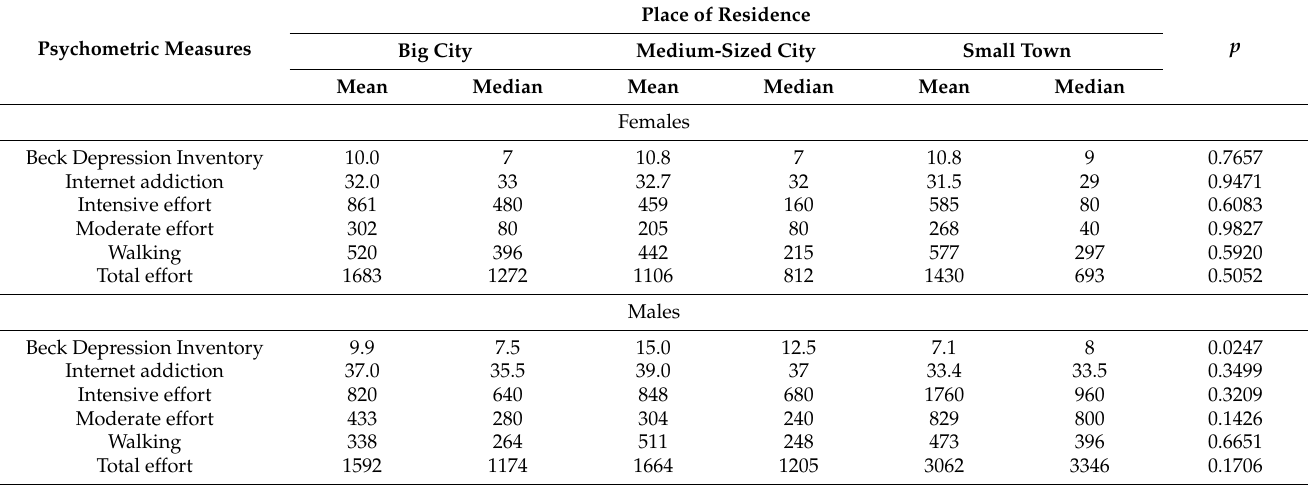
Table 3. Level of psychometric measures in relation to the place of residence.